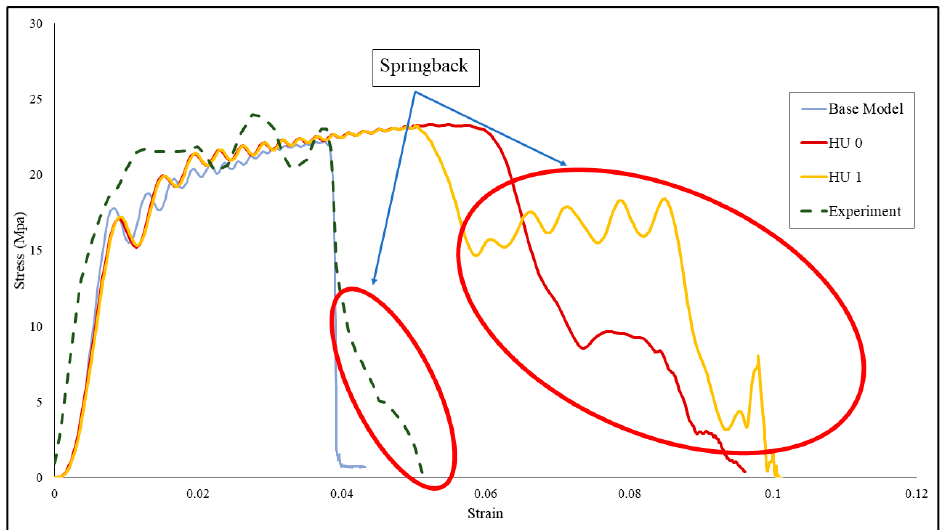
Figure 18. Comparison of stress–strain curves between the experiment and numerical model with HU values of 0, 0.01, and 1 with loading speed of 20 m/s.